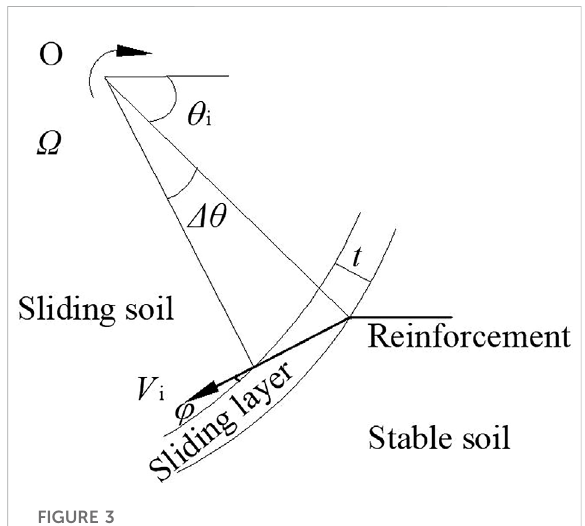
FIGURE 3 Movement mode of reinforcement in sliding layer under the log-spiral